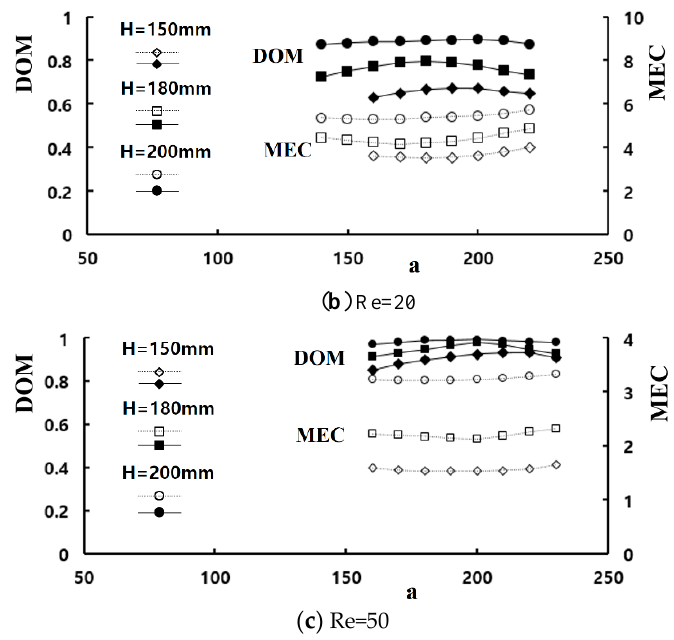
Figure 10. Variation of the DOM and MEX with the control parameter a .